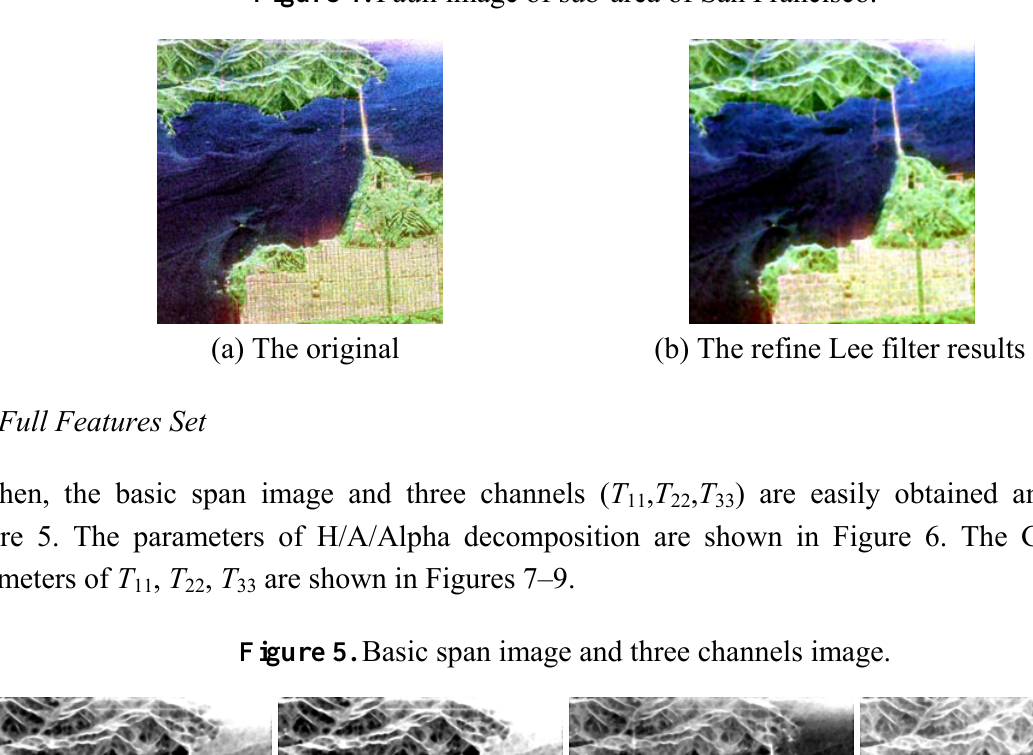
Figure 4. Pauli image of sub-area of San Francisco.